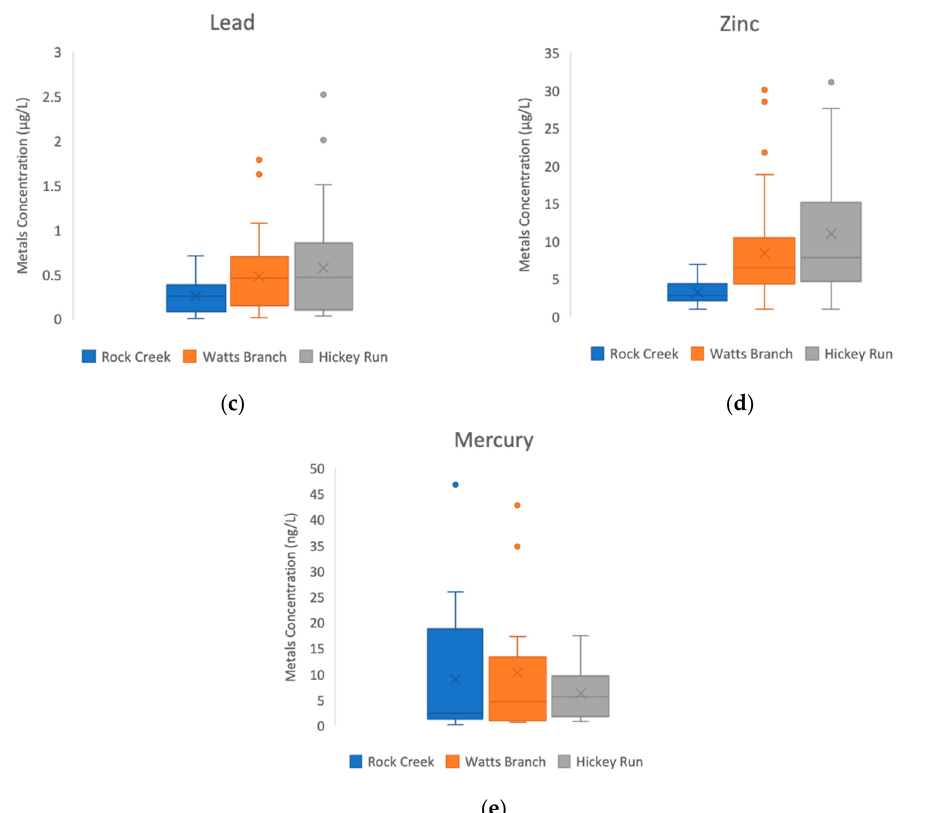
Figure 3. Concentrations of each metal ( a – e ) for the Rock Creek, Hickey Run, and Watts Branch watersheds.